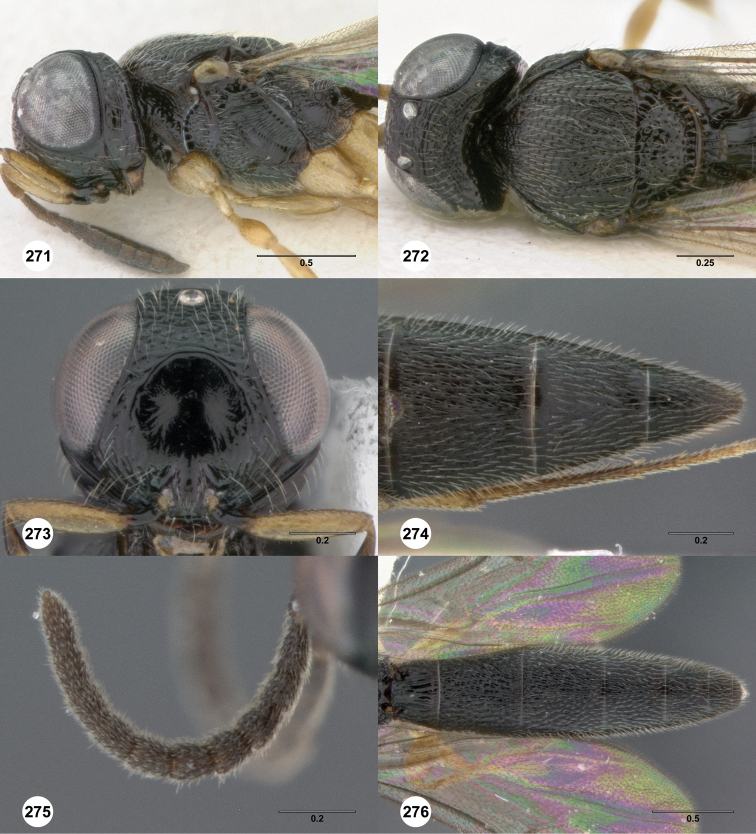
Oxyscelio radii sp. n., holotype female (OSUC 368185) 271 Head and mesosoma, lateral view 272 Head and mesosoma, dorsal view. Paratype female (OSUC 368178) 273 Head, anterior view 274 Metasoma, dorsal view. Paratype male (OSUC 368190) 275 Antenna 276 Metasoma, dorsal view. Morphbank80